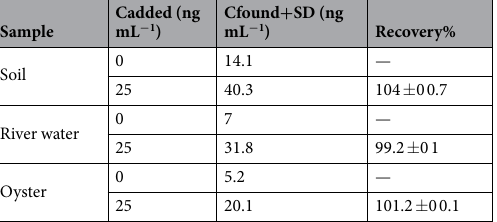
Table 2. Results of blank and spiked recoveries of copper in real environmental samples.